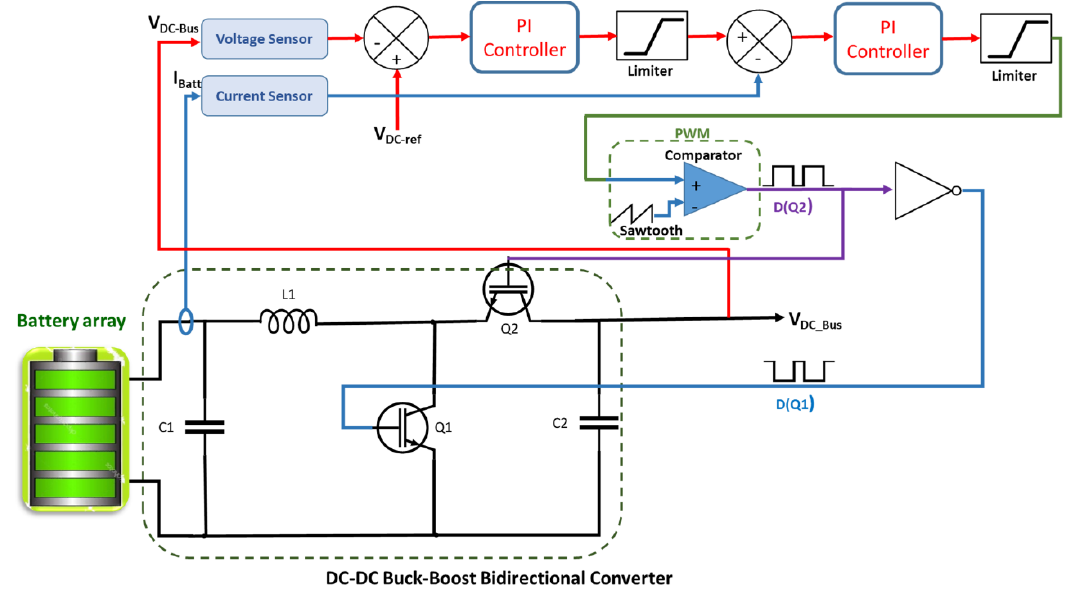
Figure 8. Schematic diagram of bidirectional converter with controller. Table 3. Design parameters of the bidirectional converter circuit.